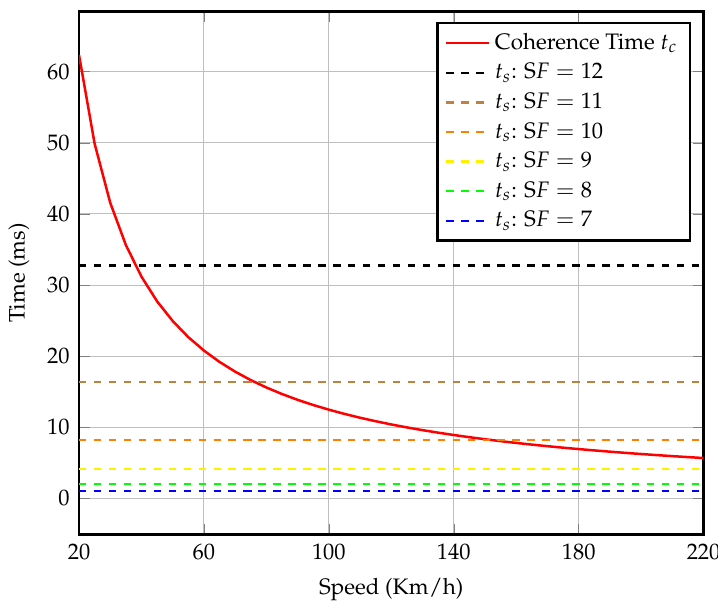
Figure 4. Symbol times for different spreading factors and coherence time with mobility.